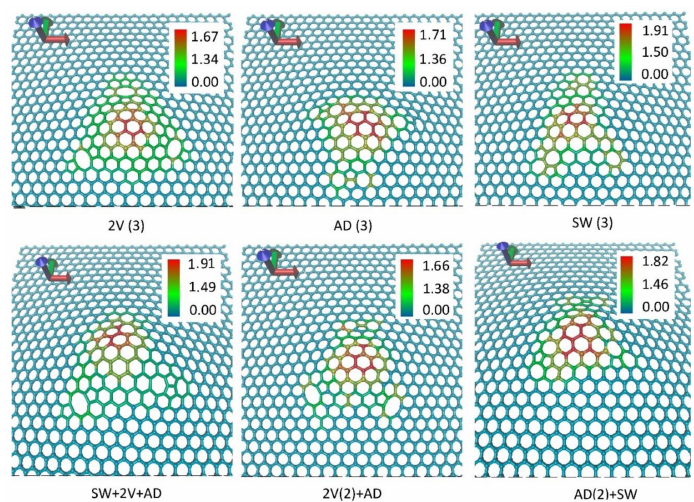
Figure 2. Maps of the local atomic stress of investigated graphene nanoblisters for various defects. A calibration scale of stresses in GPa is indicated in the top right corner of each